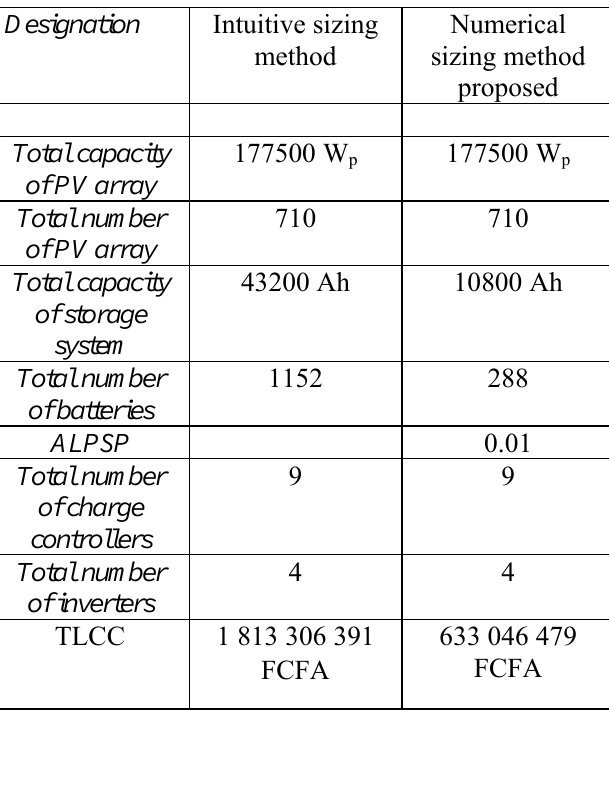
Table 2. Comparison between intuitive method and numerical method proposed